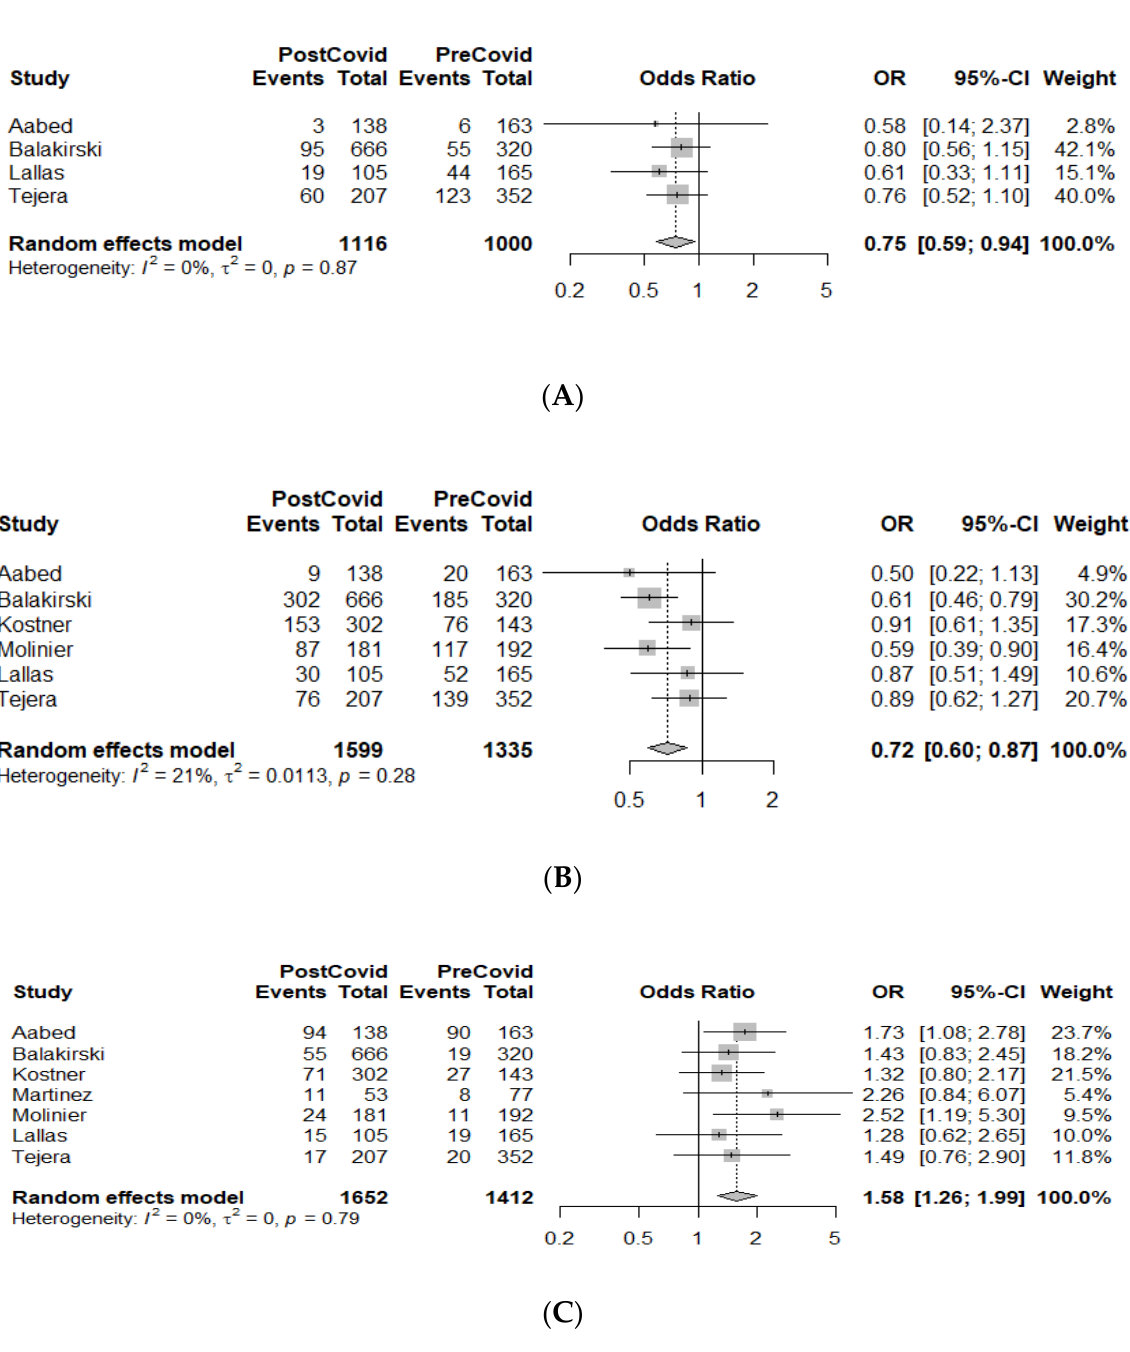
Figure 4. ( A ). Forest plot of AJCC Stage 0 results for the PreCovid and PostCovid groups. ( B ). Forest plot of AJCC Stage I results for the PreCovid and PostCovid groups. ( C ). Forest plot of AJCC Stage III results for the PreCovid and PostCovid groups.